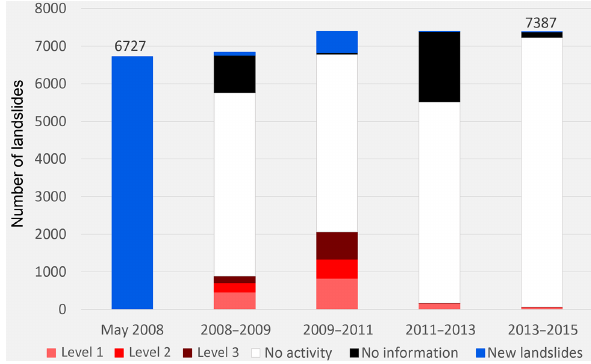
Figure 11. Activity levels of the five landslide